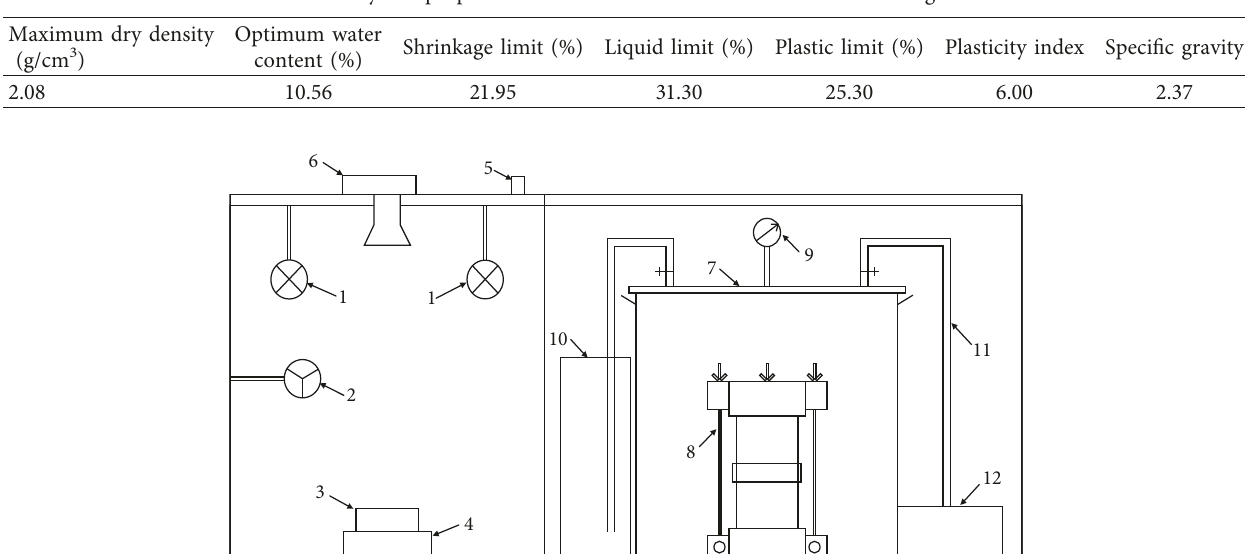
Figure 2: X-ray diffraction patterns of the completely disintegrated carbonaceous mudstone. Table 1: Physical properties of carbonaceous mudstone after full disintegration.